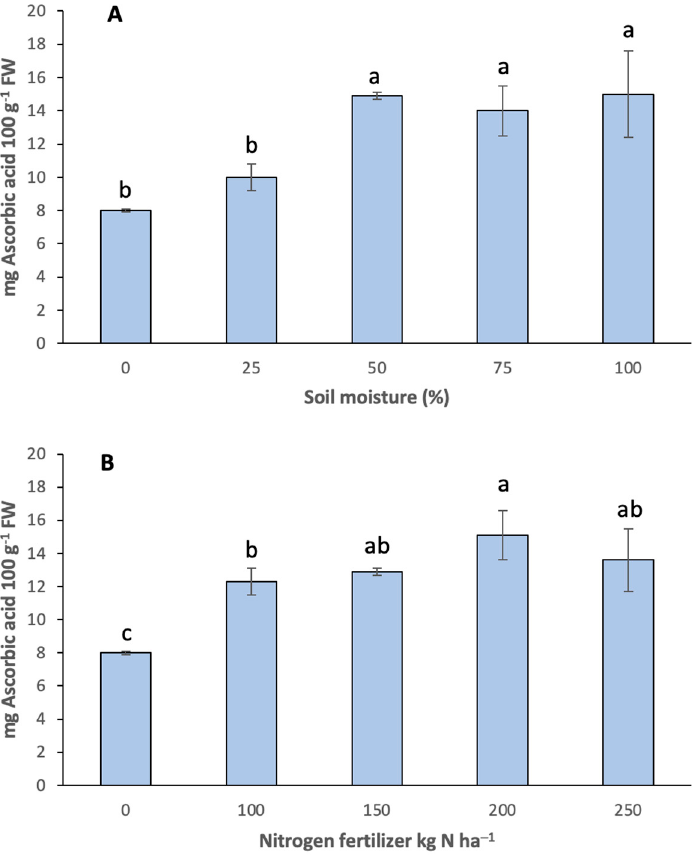
Figure 3. Onion ascorbic acid content at different ( A ) soil moistures and ( B ) nitrogen fertilization. Different letters indicate significant difference ( p < 0.05). Media ± standard deviation of three repetitions. FW = fresh weight.